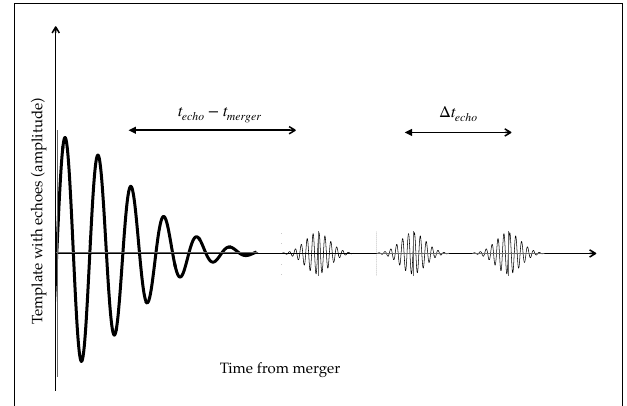
Figure 7. Figure demonstrating an echo template. Here ∆ t echo denotes the time-delay between two consecutive echoes; also, the horizontal line shows the time delay between binary merger and the first echo. (In Reference [176], the time domain template along with the best-fit echoes template for GW150914 from a template-based echo analysis is